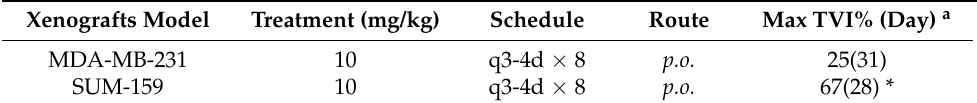
Table 2. Anti-tumor activity of selinexor in TNBC